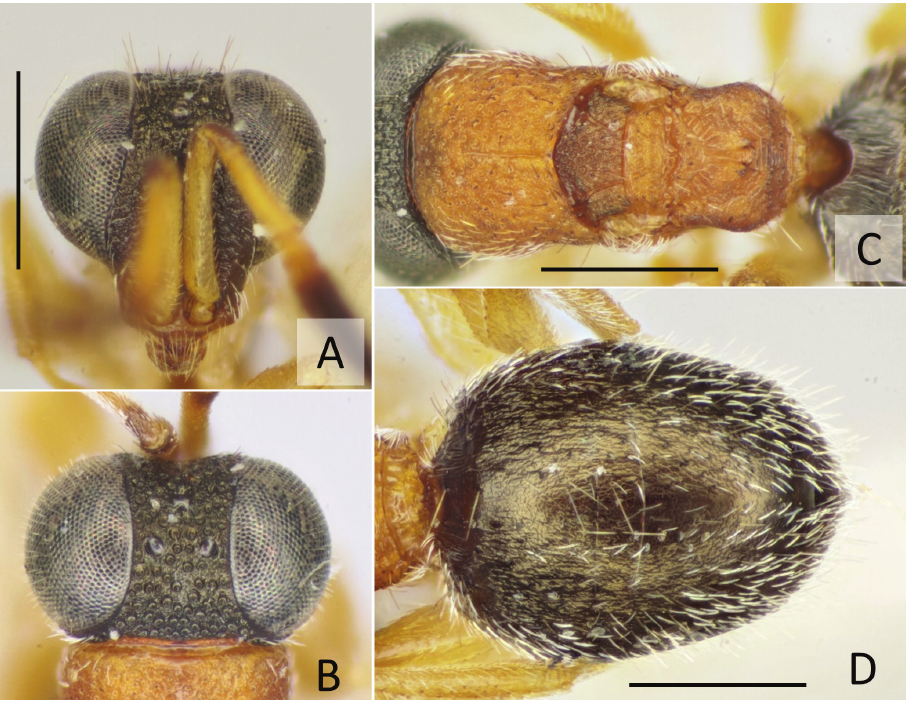
Figure 5. Baeosega torrida Krombein, holotype ♀ A head in frontal view B ditto, dorsal view C mesosoma D metasoma. Scale bars: 0.5